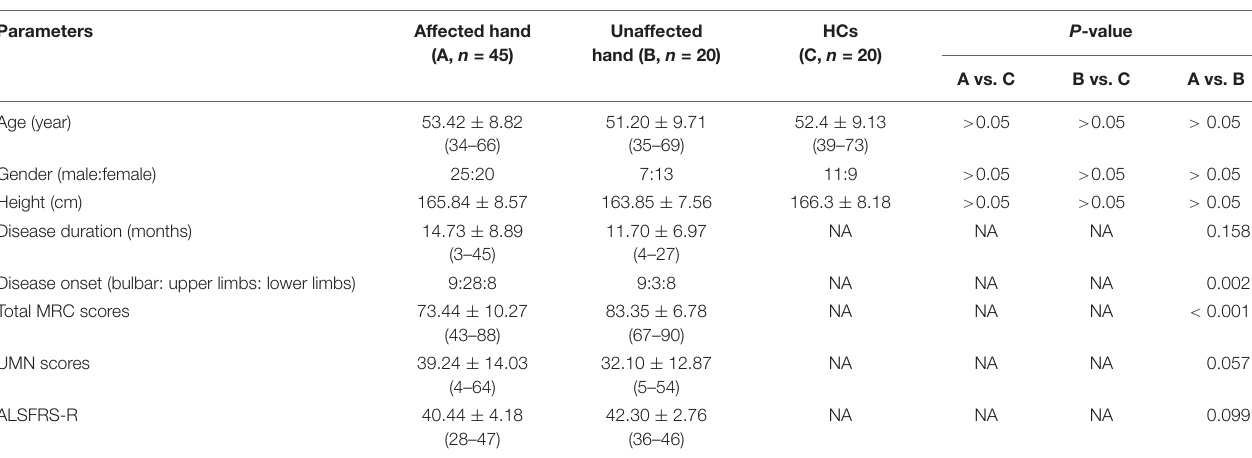
TABLE 1 | Clinical profile of